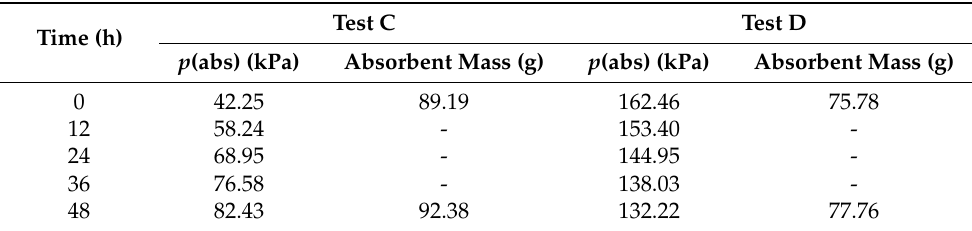
Table 4. Real-time measurement data of Test C and Test D, which were performed considering opposite directions of nitrogen permeation.